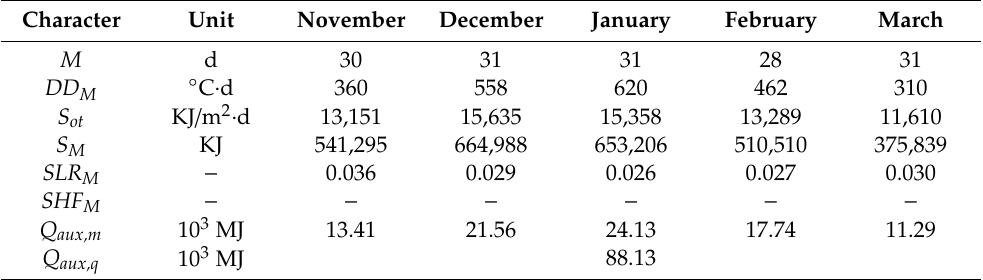
Table 16. Calculation for the yearly auxiliary energy demand in adobe residential buildings.